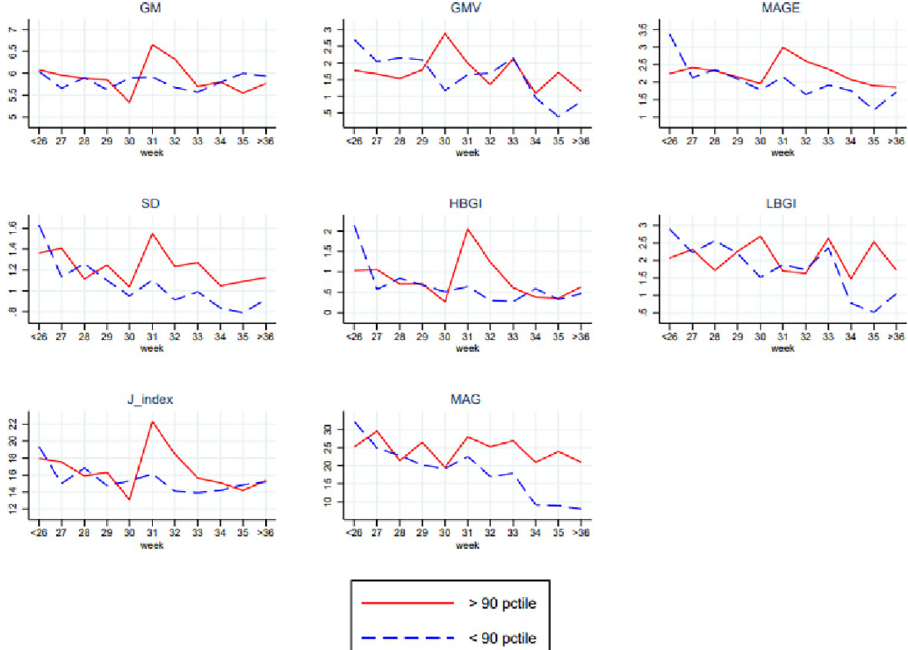
Fig 1. Trends in parameters of glycaemic variability by foetal growth. GM = Glycaemic Mean; GMV = Glycaemic Mean Value; HBGI = High Blood Glucose Index; LBGI = Low Blood Glucose Index; MAG = Mean Absolute Glucose; MAGE = Mean Amplitude of Glucose Excursions; SD = Standard Deviation. Adjusted values reported (see the Statistical analysis sub-section for details).